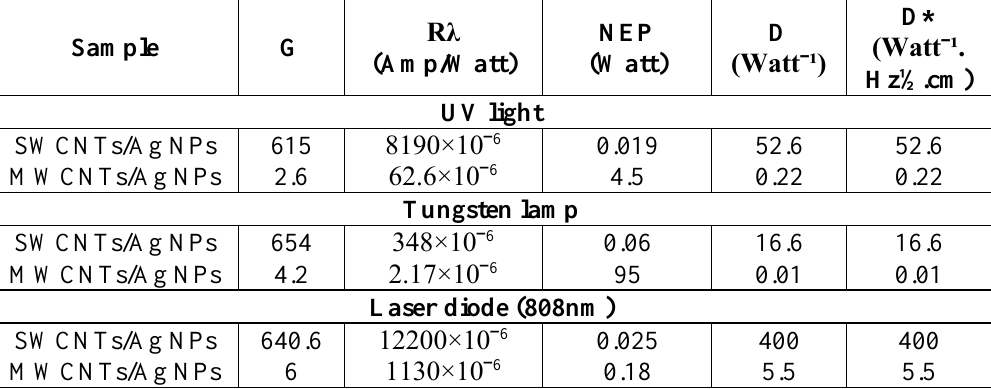
Table 2: Figure of merits photoconductive detector on silicon layer with coating polymer.